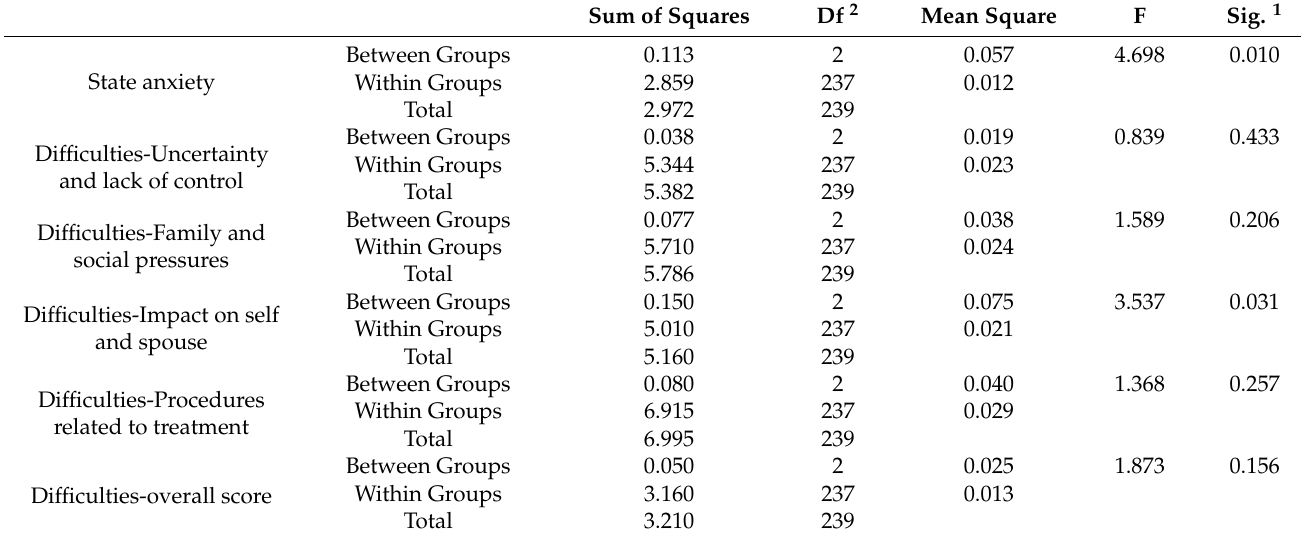
Table 2. Analysis of the variance of anxiety and difficulties scores of the women in the study for different levels of